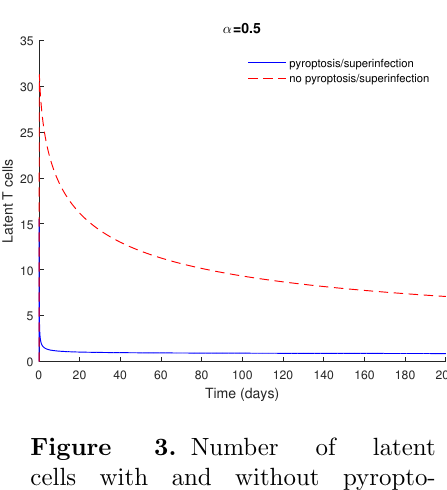
Figure 3. Number of latent cells with and without pyropto- sis/superinfection, for α = 0 . 5. Parameter values and initial condi- tions in the